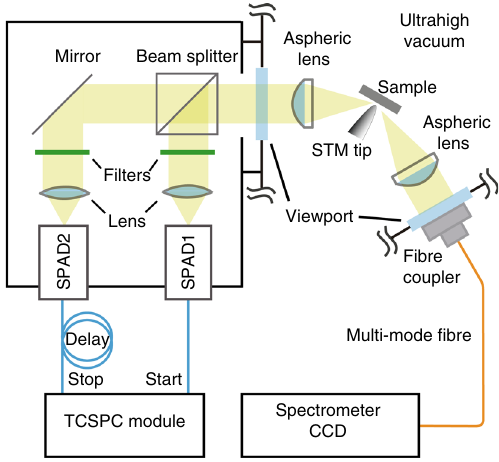
Fig. 3 HBT setup for photon correlation measurements in STML experiments. The emitted light beam along one photon collection channel is split into two parts by a beam splitter. Two band-pass fi lters are set in front of two SPADs to selectively detect photons that come from the characteristic Q(0, 0) emission of the ZnPc molecule. The other photon collection channel, symmetrical to the STM tip, is connected to a CCD spectrometer for STML spectral measurements to monitor the stability of the fl uorescent molecules. TCSPC time-correlated single-photon counting